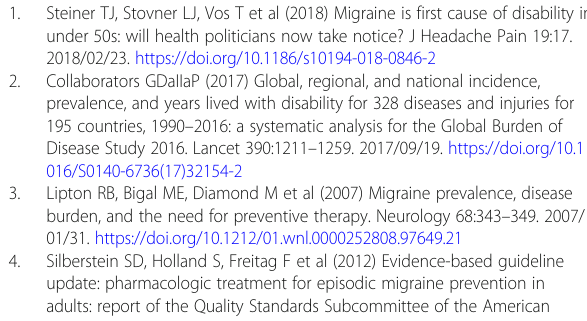
and propranolol. (DOCX 14